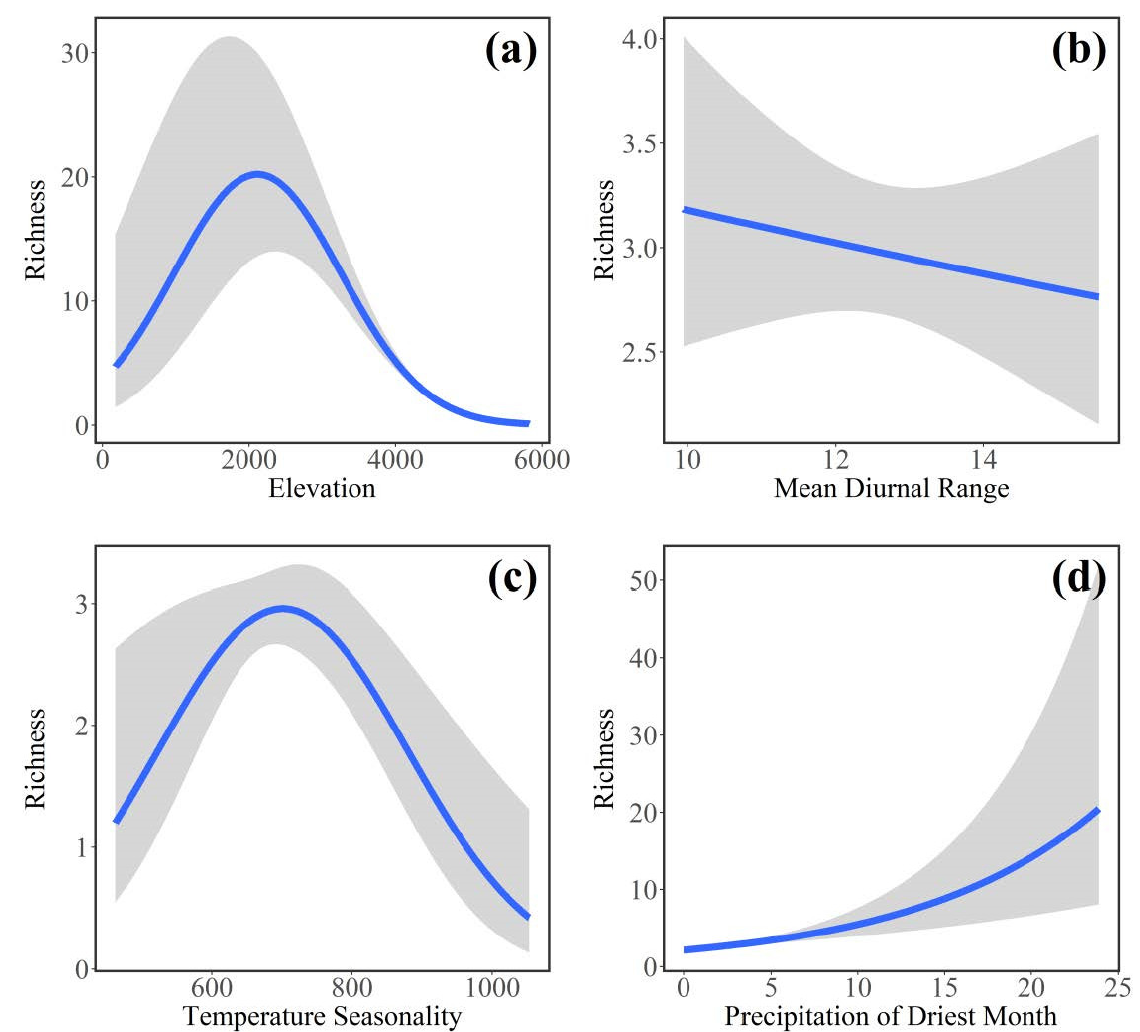
Figure 7. The relationship between four important factors selected by the random forest model and native fish richness. The gray range is the 95% confidence interval. ( a ) Ele: elevation; ( b ) Bio2: mean diurnal range; ( c ) Bio4: temperature seasonality; ( d ) Bio14: precipitation of driest month. For non-native fish richness (Figure 8), Bio4 (temperature seasonality), Bio15 (precipita- tion seasonality), Bio17 (precipitation of driest quarter), and Bio19 (precipitation of coldest quarter) were the finally selected variables in the GLM ( R 2 = 0.3). The final model showed the highest non-native fish richness when the temperature seasonality value reached